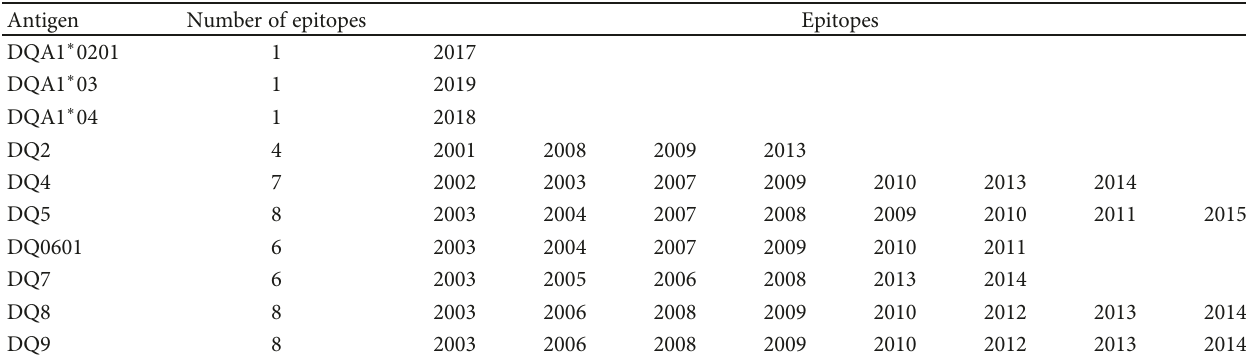
Table 8: Number and epitopes on HLA class II DQA1 and DQB1 antigens.